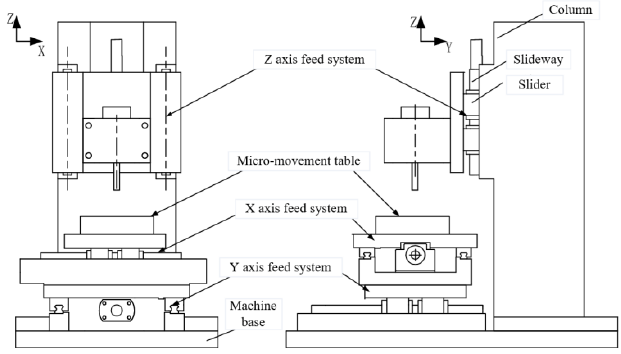
Figure 2. The structure scheme of the micro-machine tool.